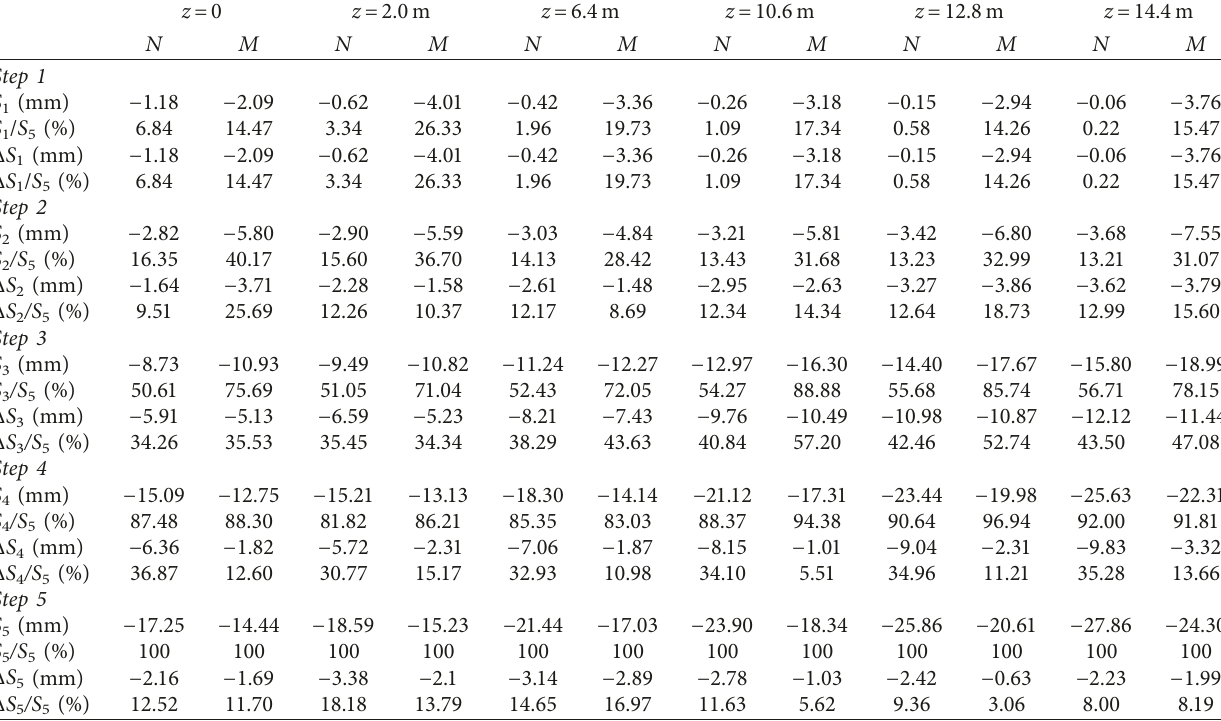
Table 3: Settlements of different subsurfaces during excavation.